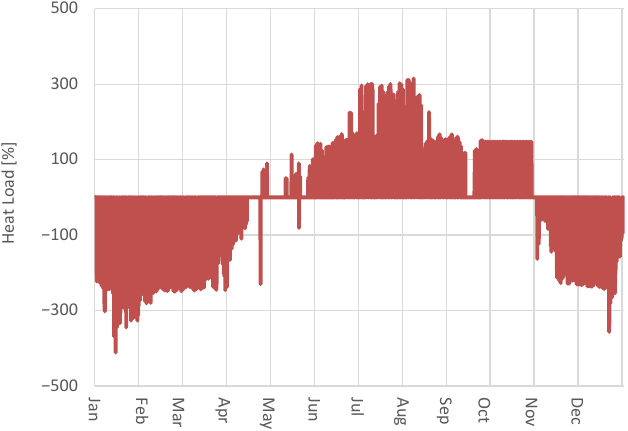
Figure 8. Annual heat source load.